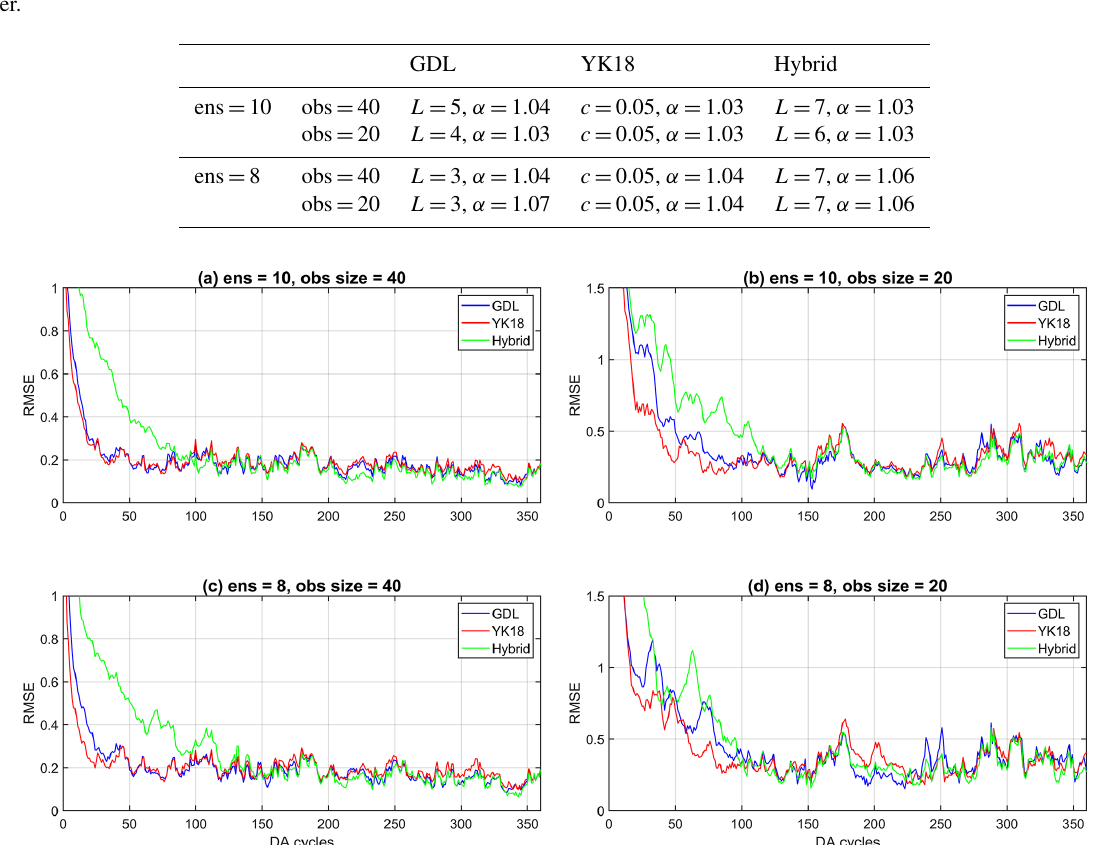
Figure 4. The time series of the analysis RMSE for GDL (blue line), YK18 (red line), and Hybrid (green line) for the cases of 10 ensembles with (a) 40 and (b) 20 observations; and cases of 8 ensembles with (c) 40 and (d) 20 observations.